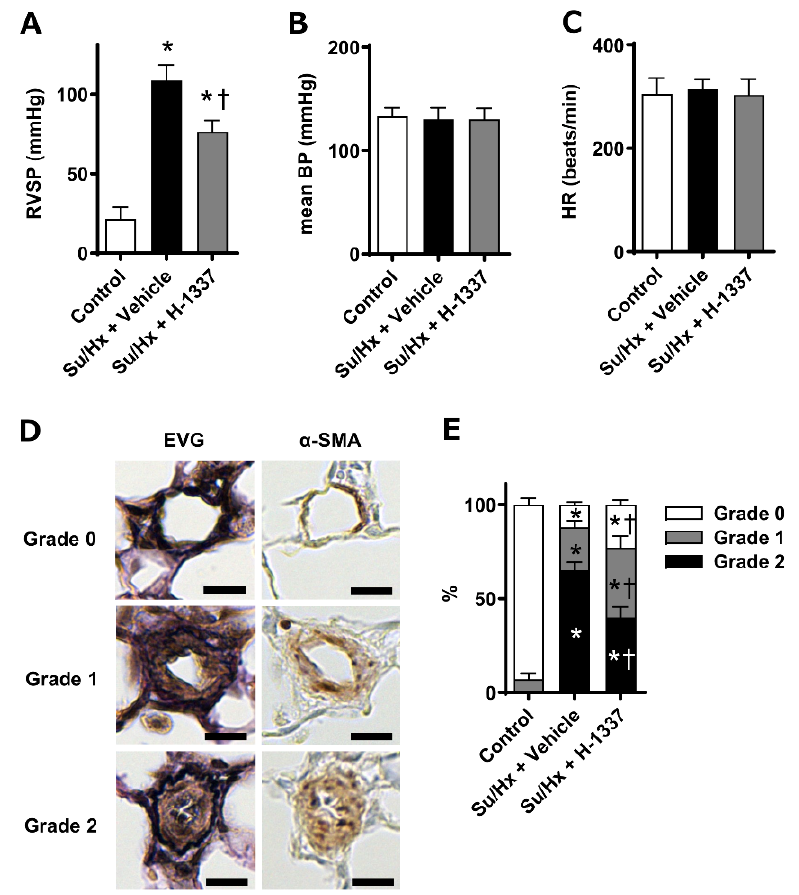
Figure 5. Suppressive effects of H-1337 on the aggravation of hemodynamics and vascular remodeling in SU5416/hypoxia (Su/Hx) rats. Hemodynamic and pathological assessment for rats were conducted at 5 weeks. ( A ) Right ventricular systolic pressure (RVSP). ( B ) Mean blood pressure (mBP). ( C ) Heart rate (HR). ( D ) Representative photomicrographs of pulmonary arteries stained with Elastica van Gieson (EVG) and immunostained with α -smooth muscle actin ( α -SMA) Scale bars indicate 10 µ m. ( E ) Quantified data from pulmonary vascular remodeling. Su/Hx + H-1337: H-1337-treated Su/Hx rats ( n = 7); Su/Hx + vehicle: vehicle-treated Su/Hx rats ( n = 6); and control: untreated rats ( n = 8). *: analyzed by ANOVA, p < 0.05 versus the control; †: p < 0.05 versus Su/Hx + vehicle.